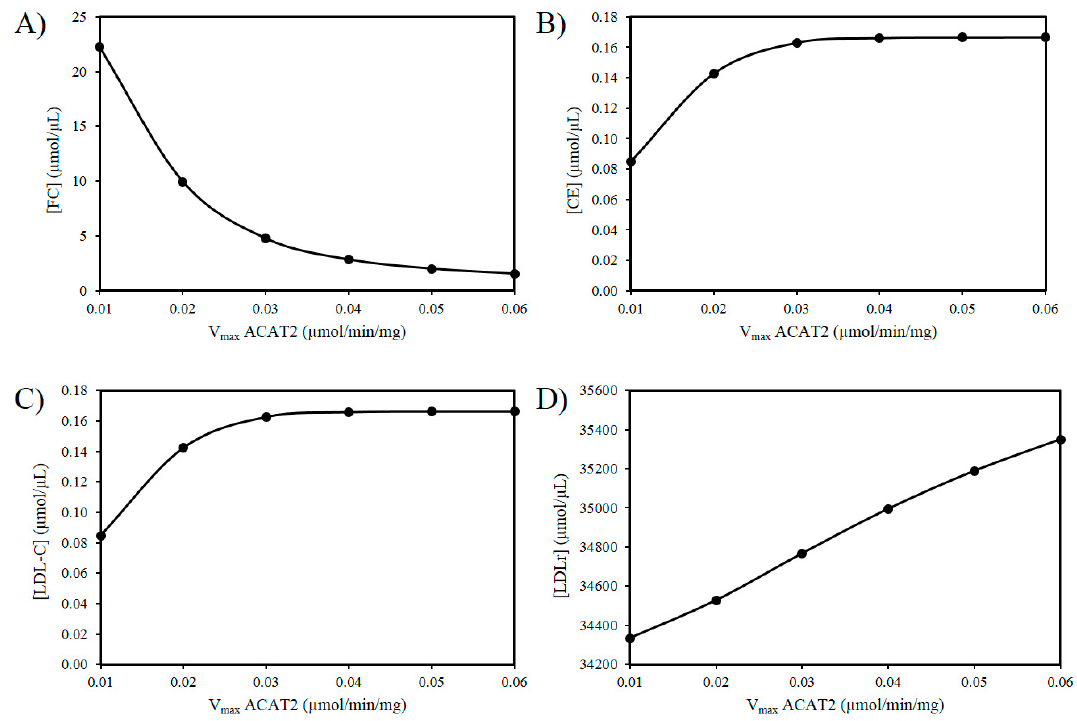
Figure 3. E ff ect of ACAT2 modulation on ( A ) FC, ( B ) CE, ( C ) LDL-C, and ( D )